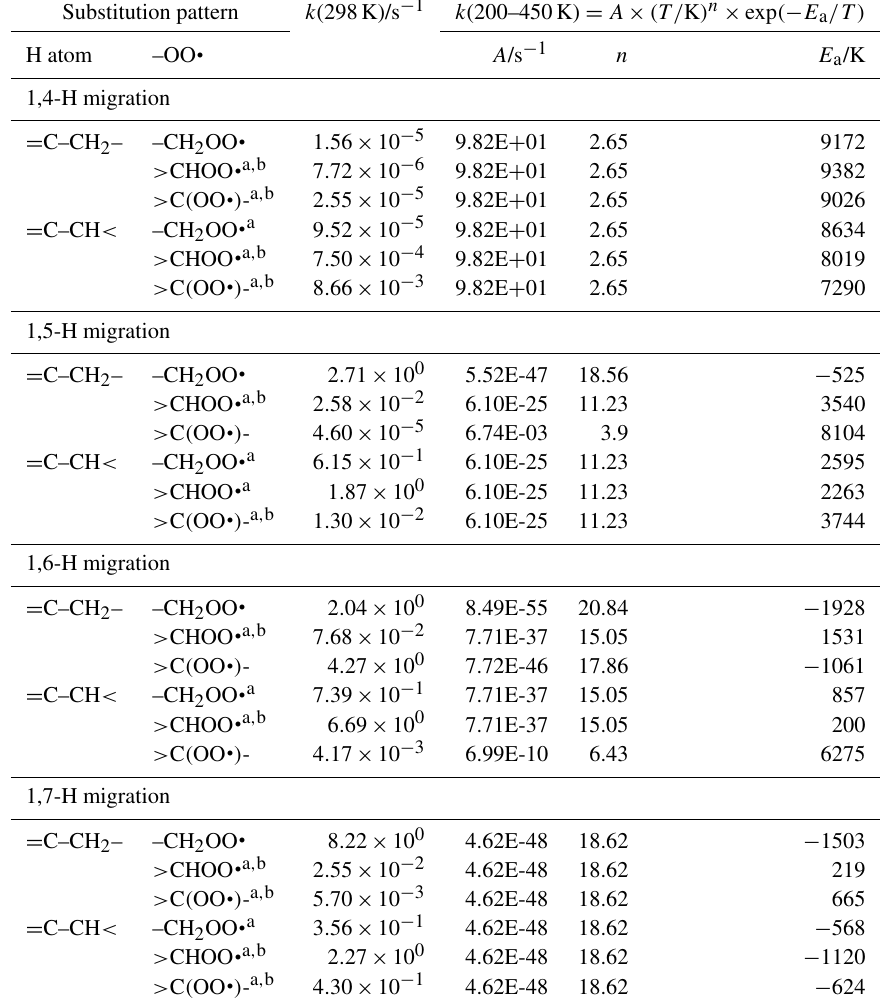
Table 3. Rate coefficients for allylic H migration in peroxy radicals with a double bond outside the TS ring, accounting for all abstractable H atoms in the